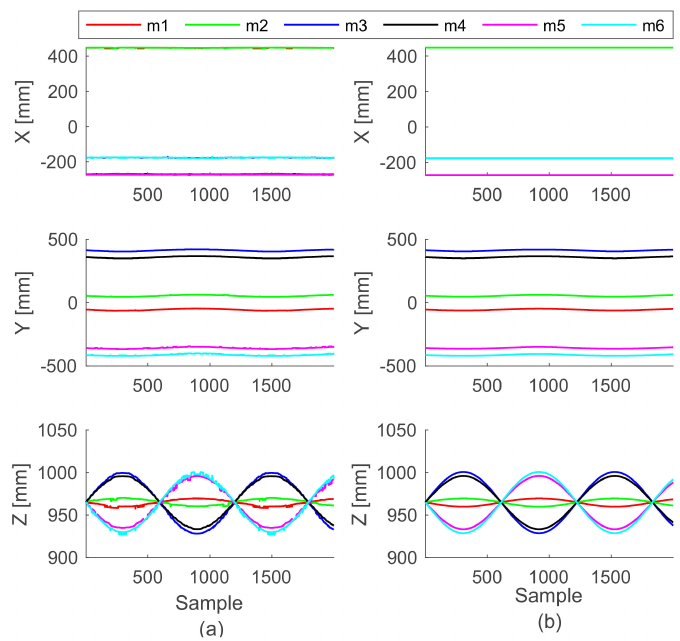
Figure 7. Cartesian coordinates of the connecting points of the mobile plate m i (one color each point) while the roll angle follows a sinusoidal time law. ( a ) Data captured by the cameras system. ( b ) Data reproduced by the simulation